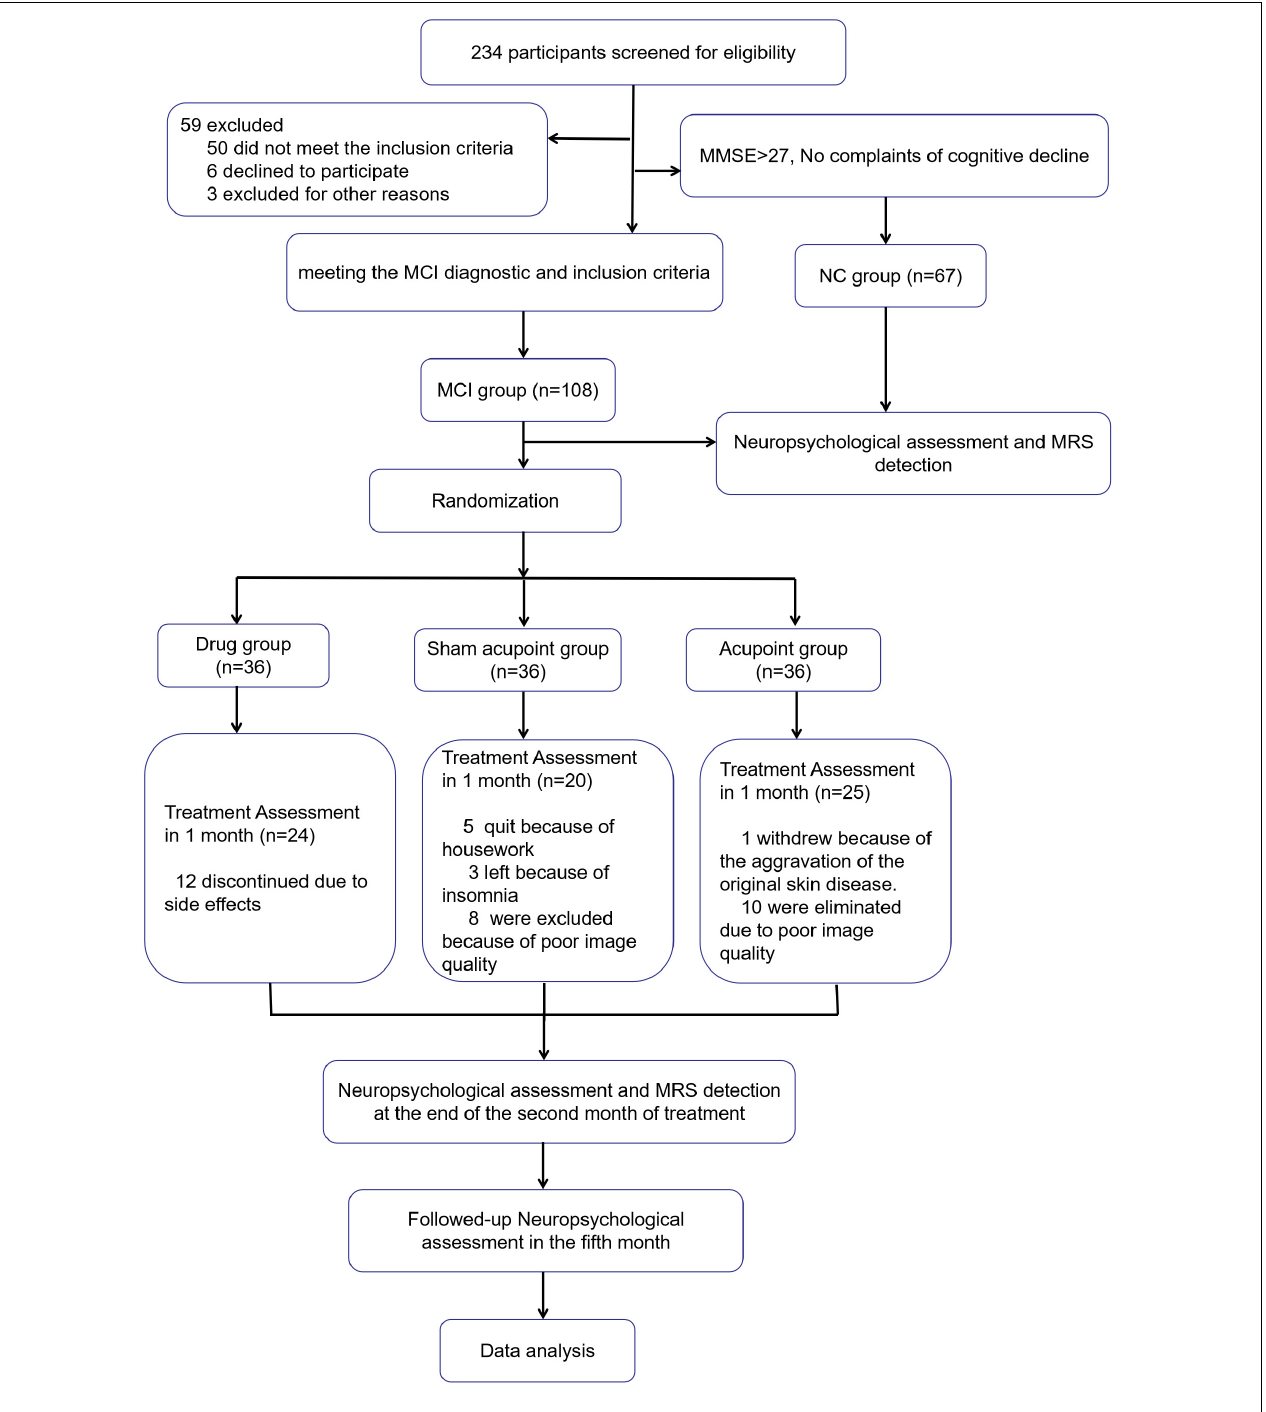
FIGURE 2 | Flowchart of the study. MMSE, Mini-Mental State Examination; MoCA, Montreal Cognitive Assessment; MCI, Mild cognitive impairment; NC, normal control.